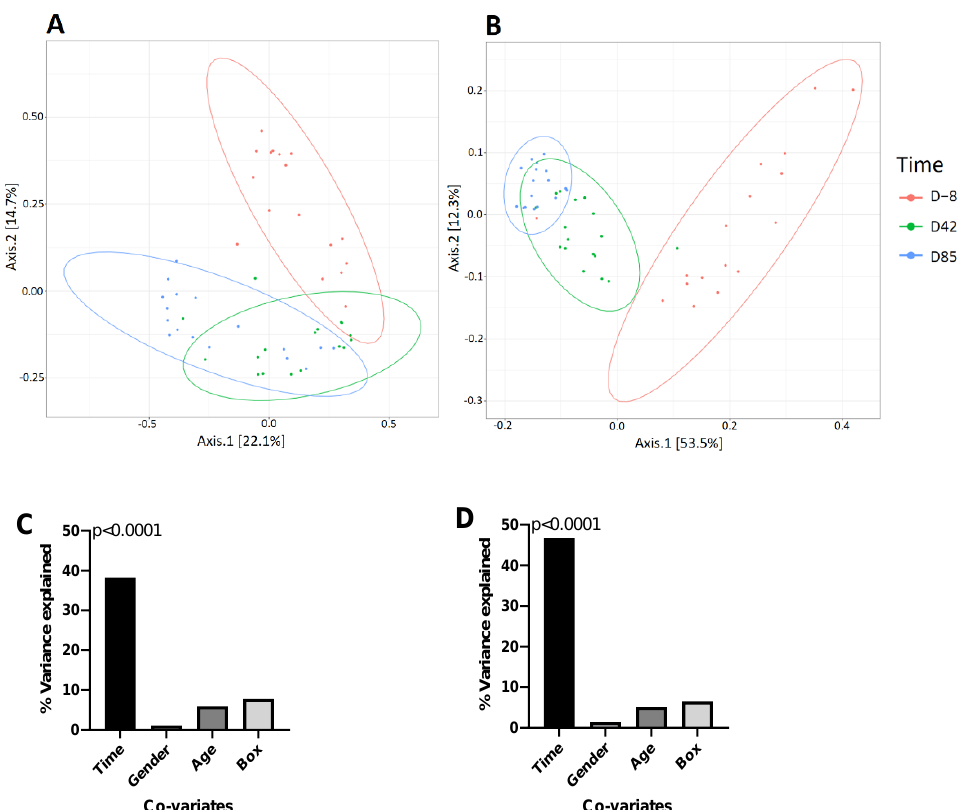
Figure 3. Beta diversity. Two-dimensional representation of PCoA plots based on ( A ) Jaccard and ( B ) unweighted Unifrac beta diversity of 16S rDNA genes. Each dot represents a sample, and each color represents a collection time: D − 8 (red), D42 (green), and D85 (blue) samples. Axis 1 is the principal coordinate component causing the largest difference in samples, with an explanatory value of 22.1% for Jaccard and 53.5% for Unifrac. Axis 2 is next, with an explanatory value of 14.7% for Jaccard and 12.3% for Unifrac. The percent of variance in ( C ) Jaccard and ( D ) unweighted UniFrac beta diversity explained by each variable. p -values were determined with PERMANOVA.